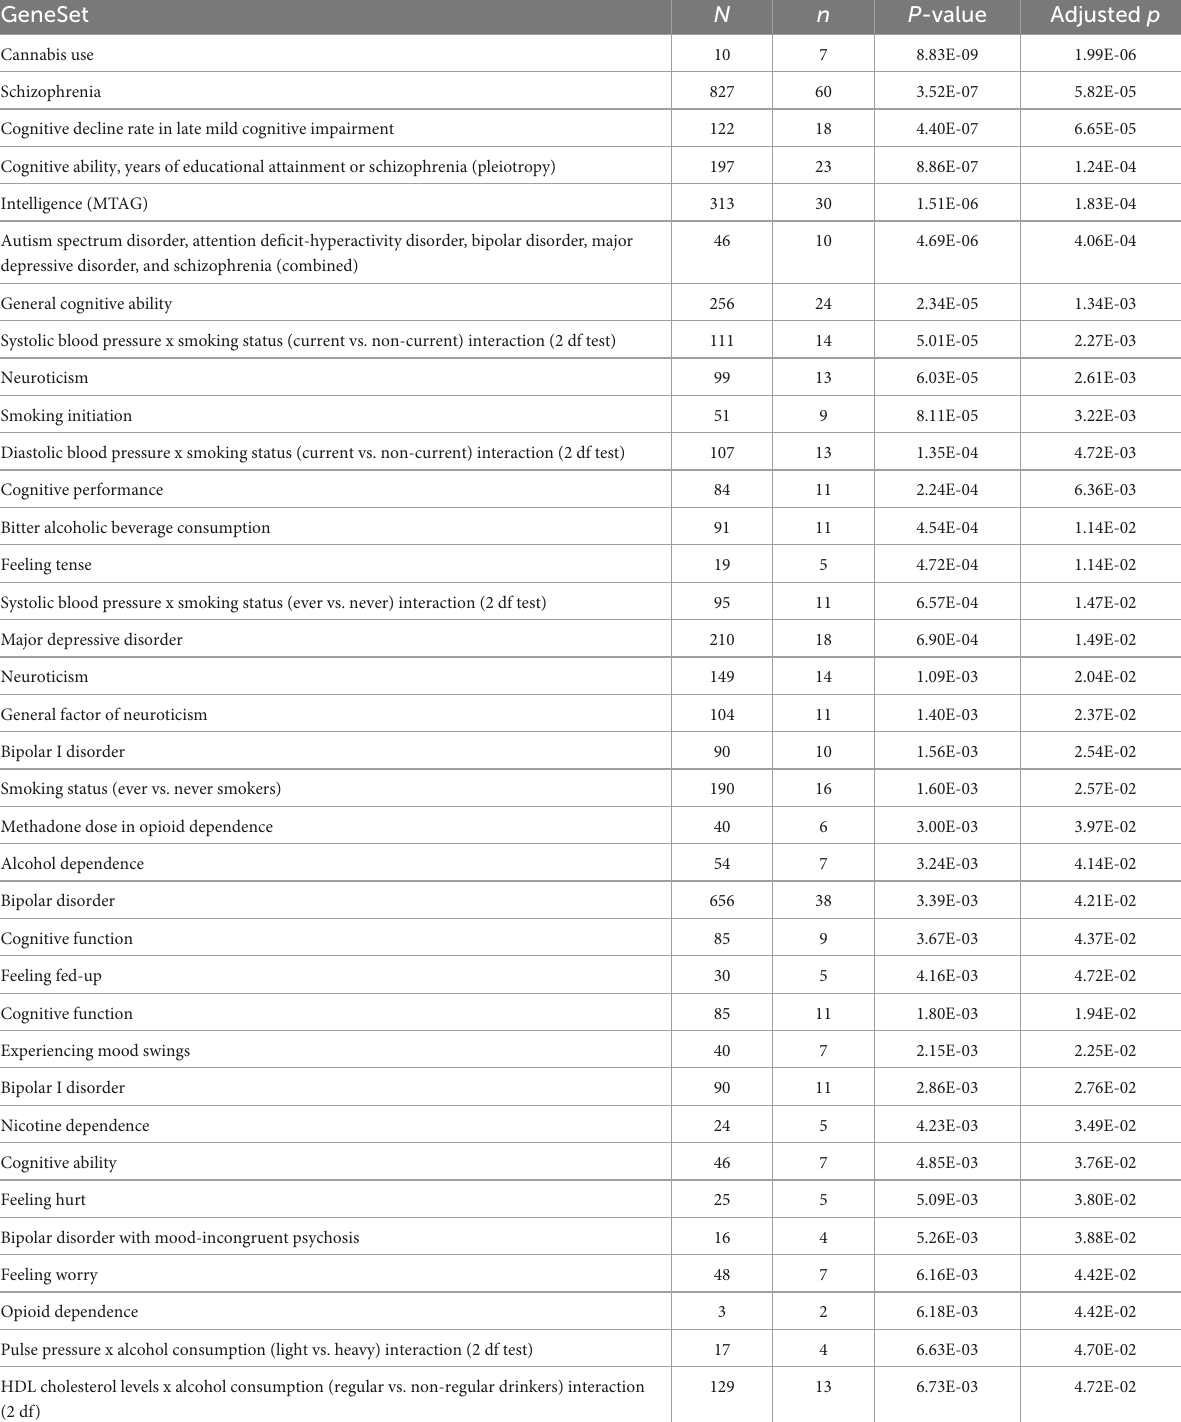
TABLE 2 Genome-wide association studies enrichment analysis of annotated genes from the OUD-associated differential mCpHs.